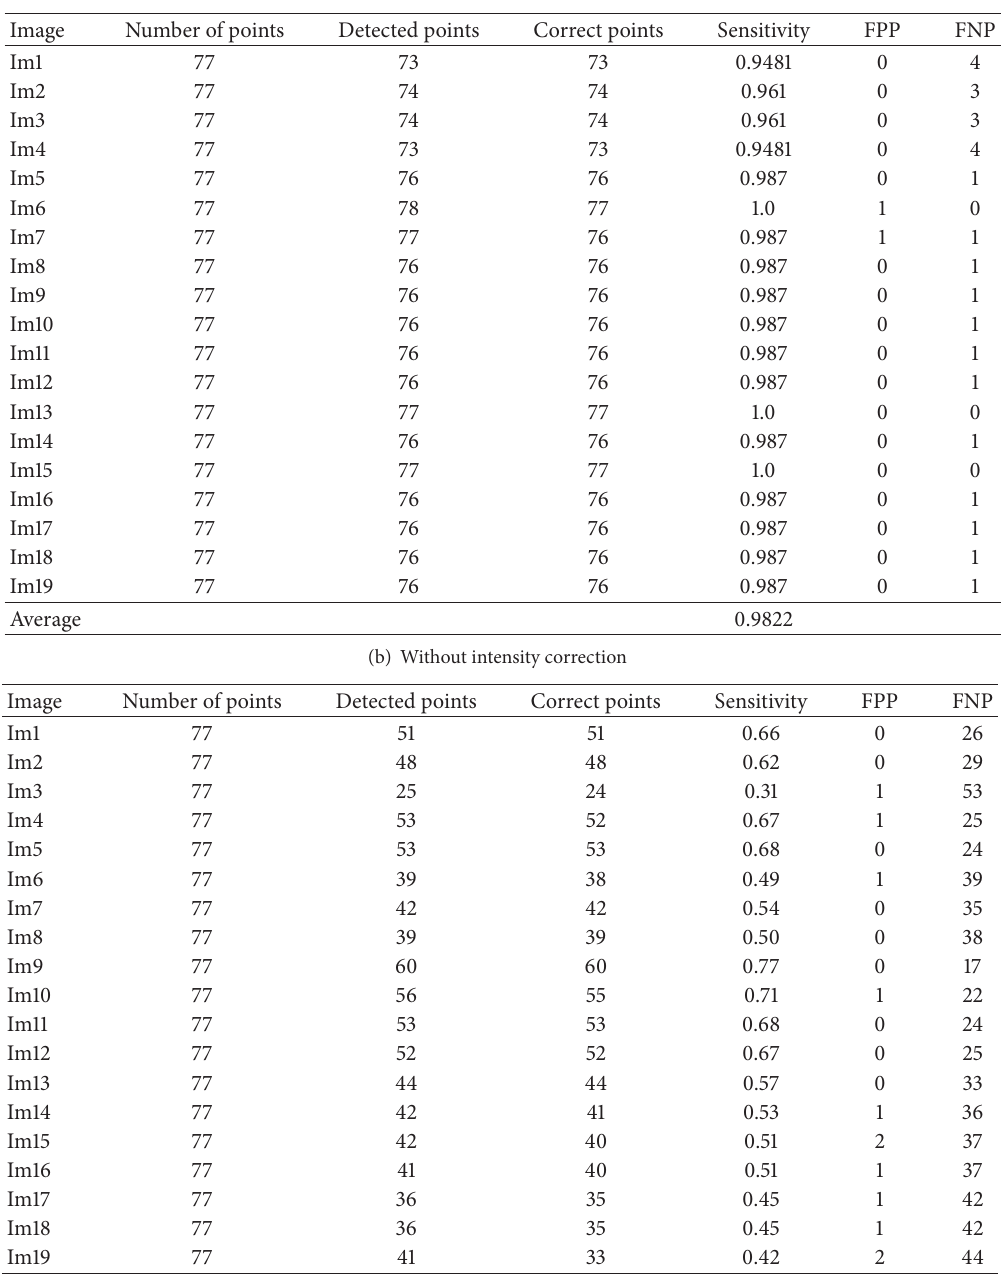
Table 1: It shows the actual number of points in each image, the number of the points detected, the number of correct points, the number of false positive points (FPP), and the number of false negative points